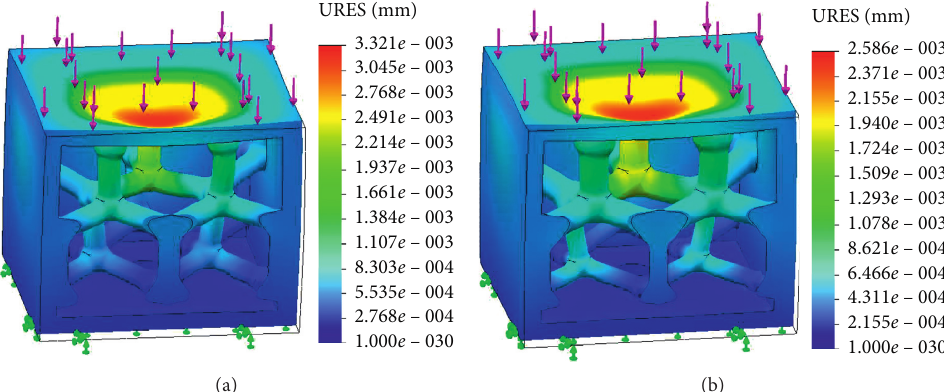
Figure 13: Comparison of displacement state. (a) The superposition of constant density units ( r � 1mm). (b) The superposition of variable density units ( r � 1.2 mm and 0.8mm).